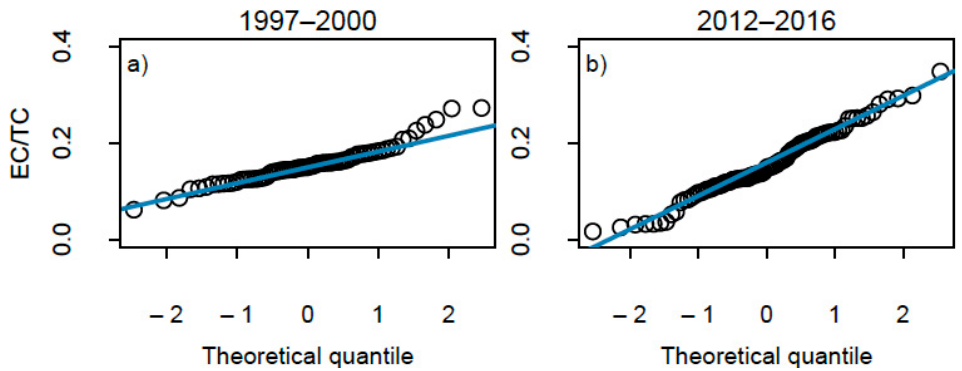
Figure 2. Box and whisker plots of total carbon (TC) concentration in fog water during the different fog seasons.